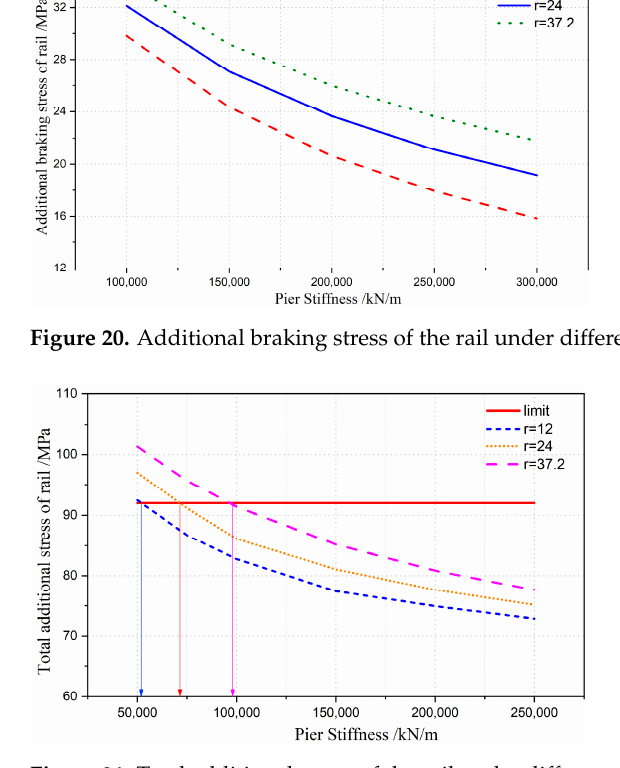
Figure 21. Total additional stress of the rail under different pier stiffness.